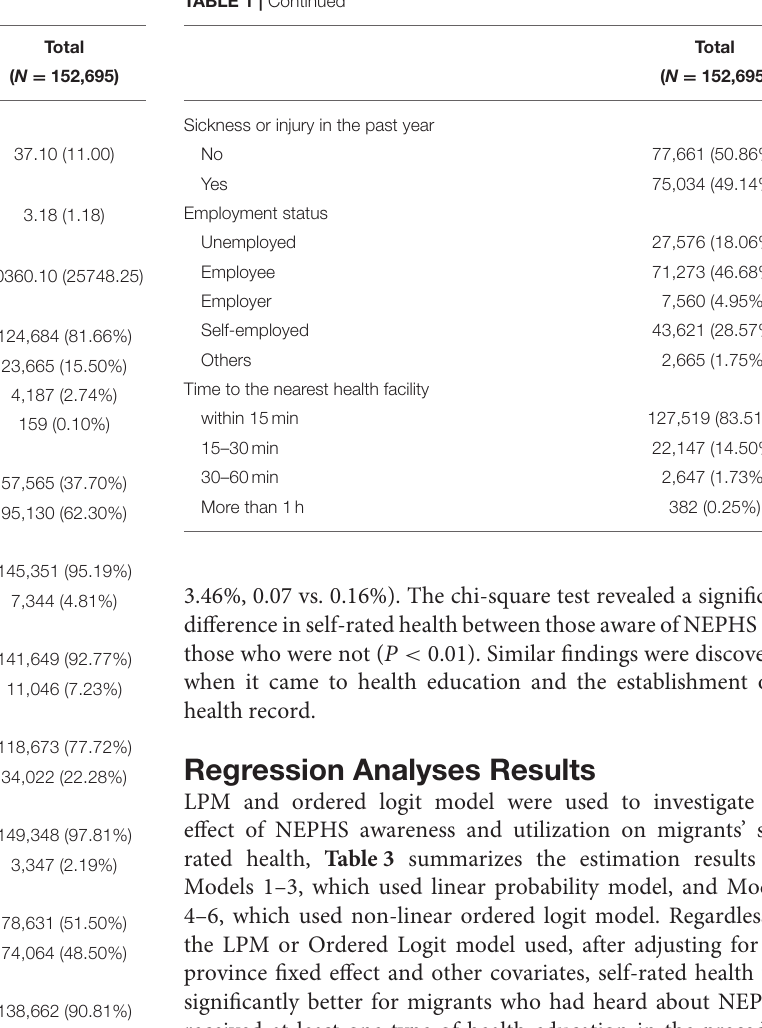
TABLE 1 | Descriptive statistics of